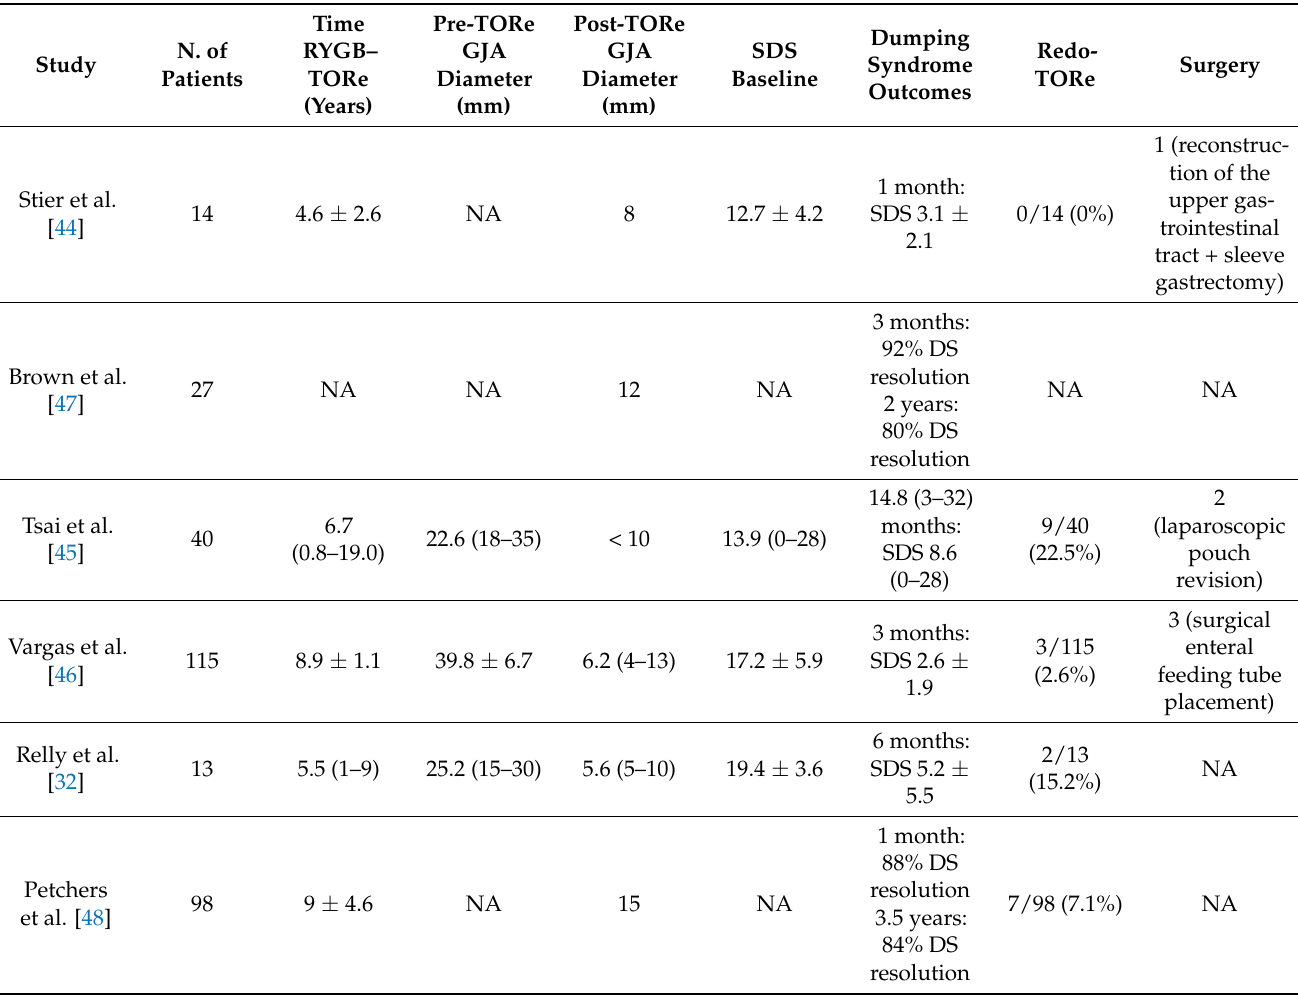
Table 2. Summary of the main studies evaluating traditional full-thickness TORe (APC-Apollo Overstitch) for dumping syndrome after gastric